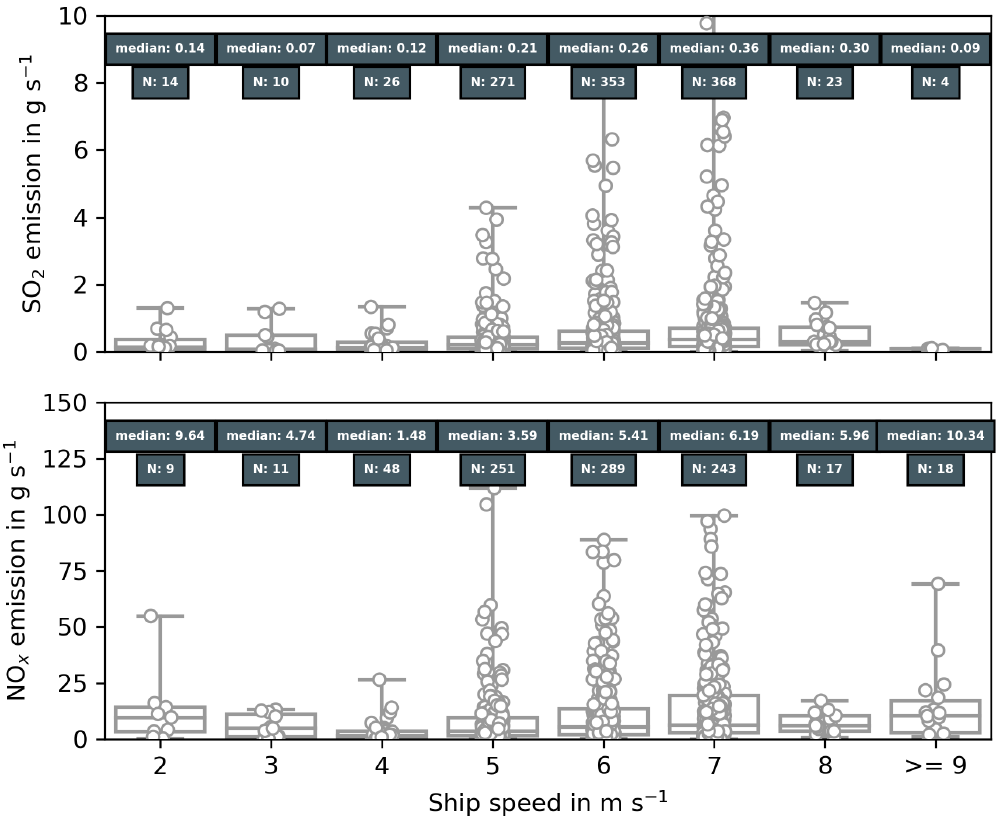
Figure 9. Box plot of SO 2 and NO x emission rates in grams per second for different ship speeds. Boxes indicate the 25th and 75th percentile, the line in the middle is the median, and the bars show minimum and maximum values. Dots show individual measurements. Boxes show the median emission rate and total number of observations for each ship speed. Table 7. Estimate of SO 2 emission rates for fuels with different fuel sulfur content, calculated for different fuel consumption under the assumption that all sulfur is converted to SO 2 during combustion. The lower value is for a fuel consumption of 165 kgh − 1 , which is typical for inland ships. The upper value is for a fuel consumption of 2000kgh − 1 , which is roughly the fuel consumption of a large container ship at a speed of 6ms − 1 (Notteboom and Vernimmen, 2009), which is the typical speed for the largest passing